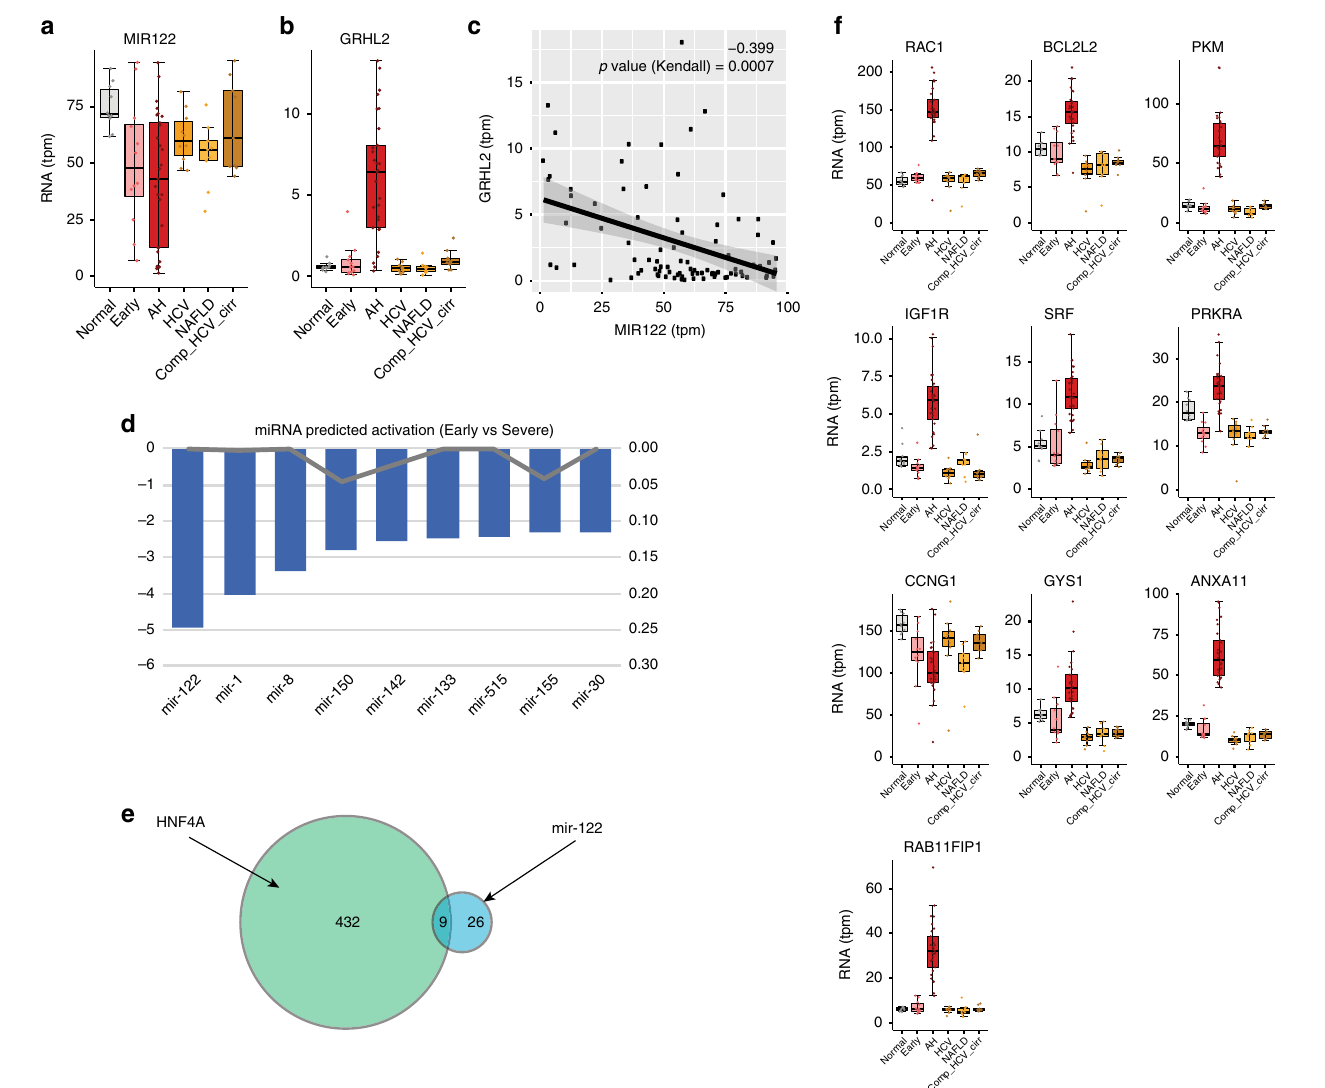
Fig. 7 miR122 levels and miR122 predicted downregulation in AH patients. a RNA levels of hpri-miR122 in our cohort b levels of Grainyhead Like Transcription Factor 2 ( GRHL2 ) in our cohort c correlation of GRH2L2 and MIR122 levels. R and p value (Kendall) are presented. d Results of miRNA predicted activity by means of IPA Upstream Regulator analysis when comparing early ASH vs AH. Top 8 miRNA are presented. e Venn diagram of the overlap between HNF4A and MIR122 targets among the differentially expressed genes in the comparison between early ASH and AH. f Box plot of most 10 validated miR122 targets (miRTarBase database) in our cohort. Box-and-whisker plots indicate 25th – 75th percentile; midline, median; whiskers, minimum to maximum values; individual data points are represented. In bold, those genes that reached FDR < 10 − 6 level of signi fi cance in DESeq2 differential expression analysis between early ASH and AH. For box-and-whisker plots: perimeters, 25th – 75th percentile; midline, median. Gene expression levels are presented in transcripts per million reads